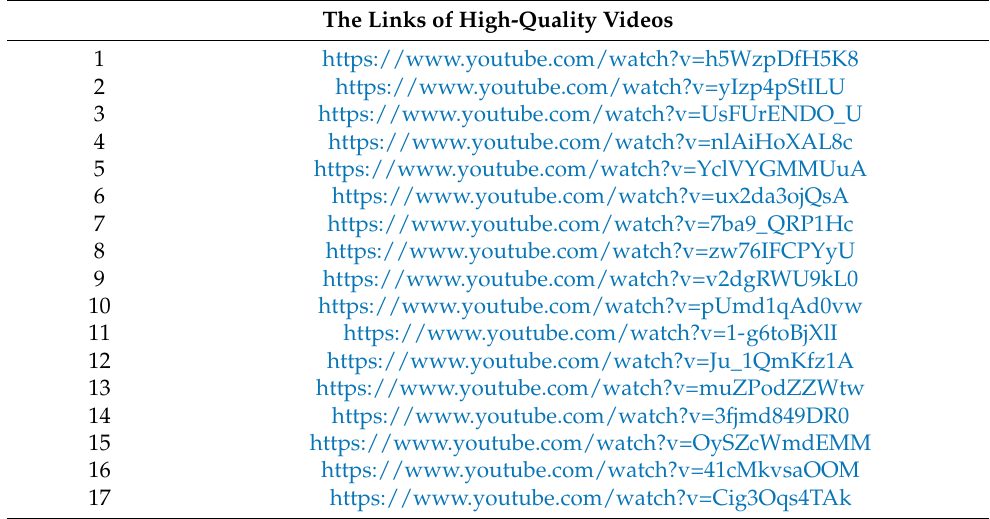
Table A1. The links of high-quality